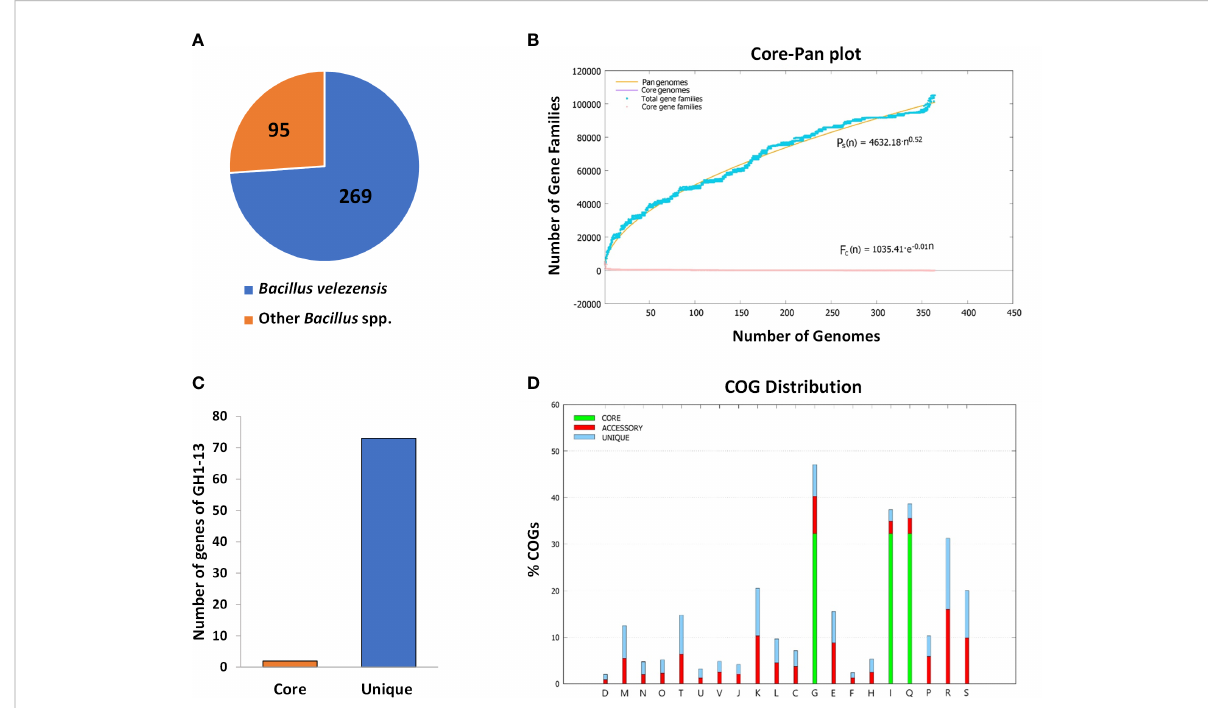
FIGURE 5 Pan-genome analysis of 364 strains within the Bacillus genus. (A) Pie chart displaying 269 strains of B. velezensis and other 95 Bacillus species. (B) 2 core genes and 73 unique genes were found in the strain GH1-13. (C) Mathematical modeling of pan-genomes and core genomes of Bacillus strains. (D) Detailed distribution of cluster of orthologous groups (COG) in core, accessory and unique